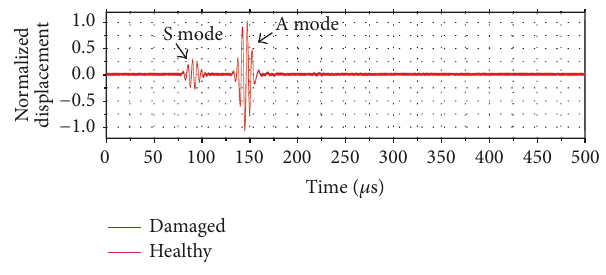
Figure 3: Lamb wave signals.